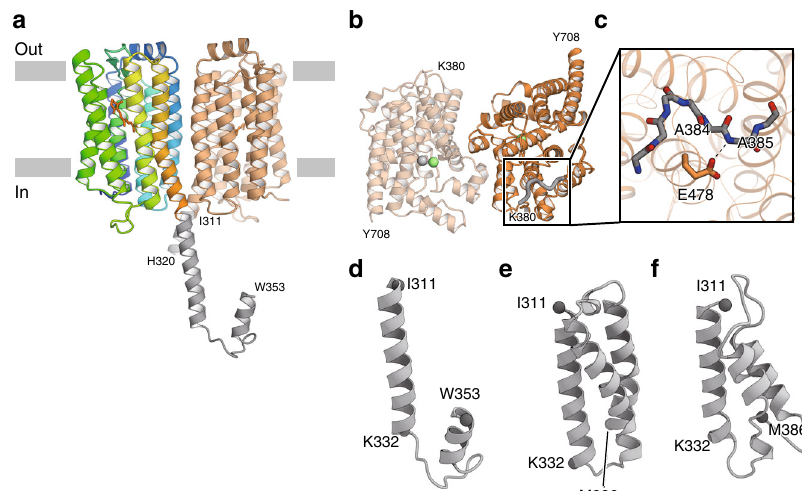
Fig. 4 Structures with the linker region. a Overall structure of Rh-PDE TMD – Linker. The linker region is colored gray. b Overall structure of Rh-PDE Linker – PDE. The newly observed region, as compared to the previous structure (PDB ID: 5VYD), is shown as gray bold coils. Zinc and magnesium ions are colored gray and green, respectively. c Glu478 and the backbone of the newly observed region are shown as stick models. Dashed lines show hydrogen bonds. d Ribbon diagrams of the linker structure of Rh-PDE TMD – Linker. e Ribbon diagrams of the linker region structure, modeled with Rosetta. f Ribbon diagrams of the fi nal structure from the aMDdual